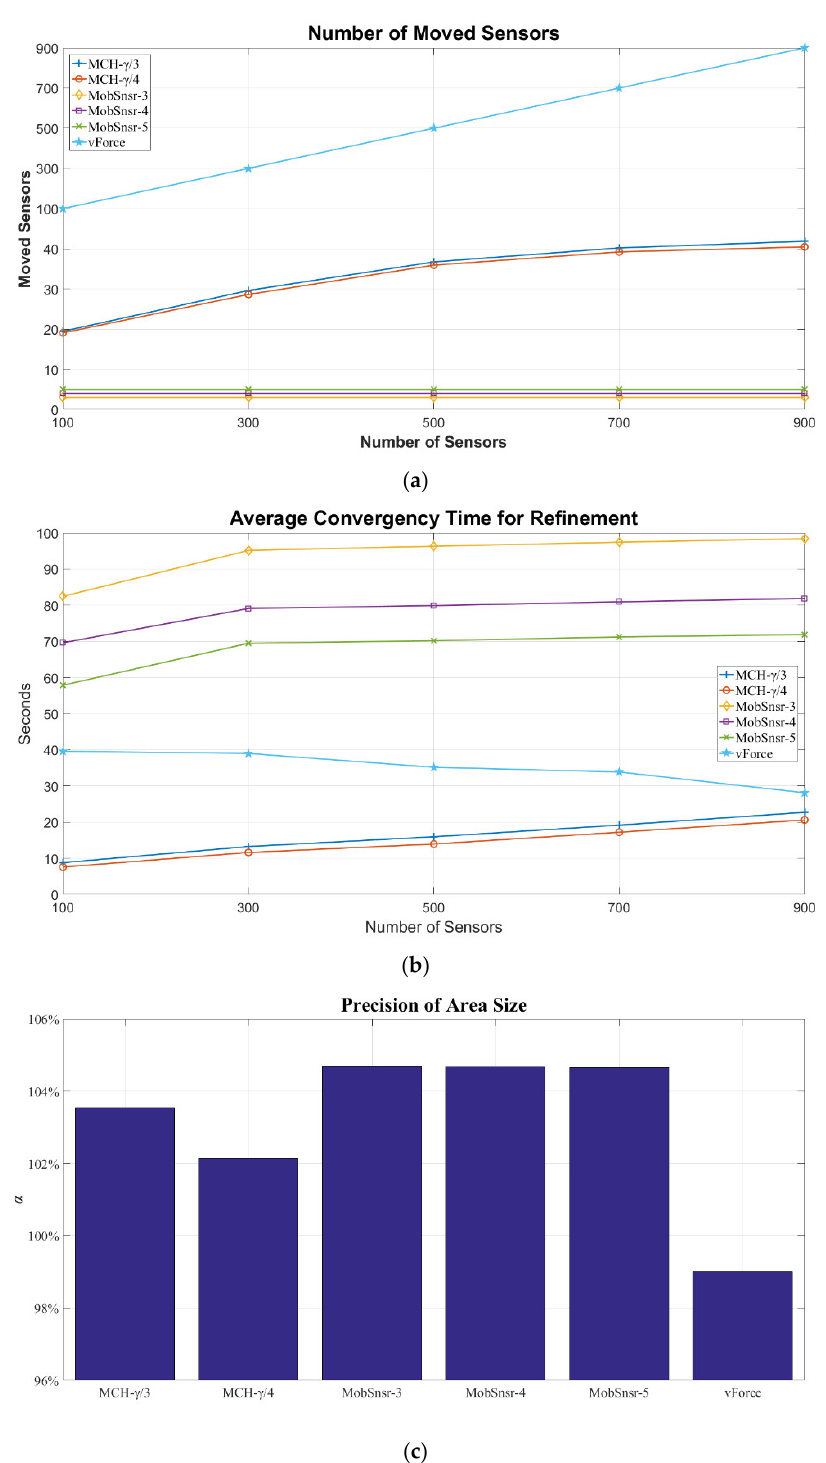
Figure 9. The Number of Moving Sensors and the Convergency Time of Refinement. The experiment evaluates the number of moving sensors and the convergency time of the algorithm for moving to the stable state. ( a ) The number of moving sensors of MCH and the method in [15]. ( b ) The average convergency time for moving sensors to meet the stable status. ( c ) The precision of the enclosed area. Figure 9a shows the number of moving sensors used for refining the boundary. The number of mobile sensors in MobSnsr is steady, but the proposed MCH adapts the moving sensors according to the initial deploying topology. Although MCH moves more